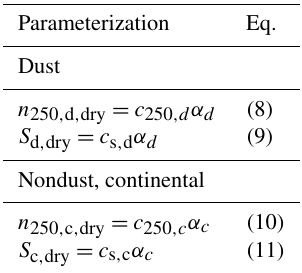
Table 3. Overview of the AERONET-based parameterizations used in this study for the conversion of the measured optical aerosol prop- erties ( α d , α c ) into the microphysical properties ( n 250 , d , dry , S d , dry , n 250 , c , dry and S c , dry ). The parameterizations were introduced in Mamouri and Ansmann (2016). In the equations, α is in per